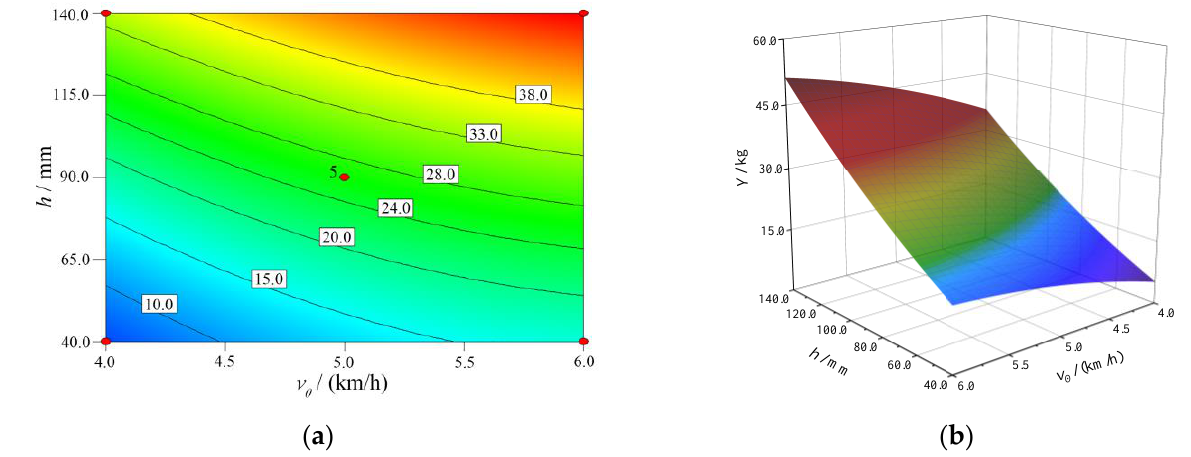
Figure 7. Influence of the forward speed and working depth on the soil-hilling quantity. ( a ) Contour map; ( b ) response surface diagram.